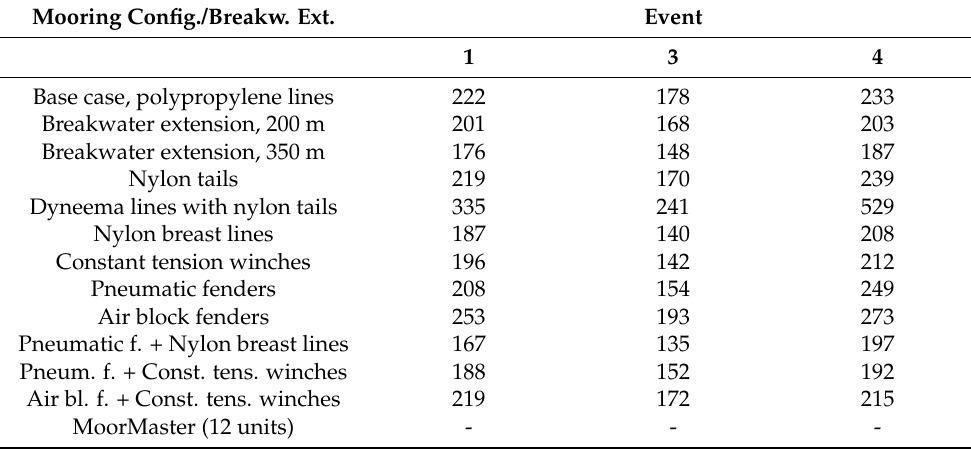
Table 10. Maximum forces in bow or stern lines